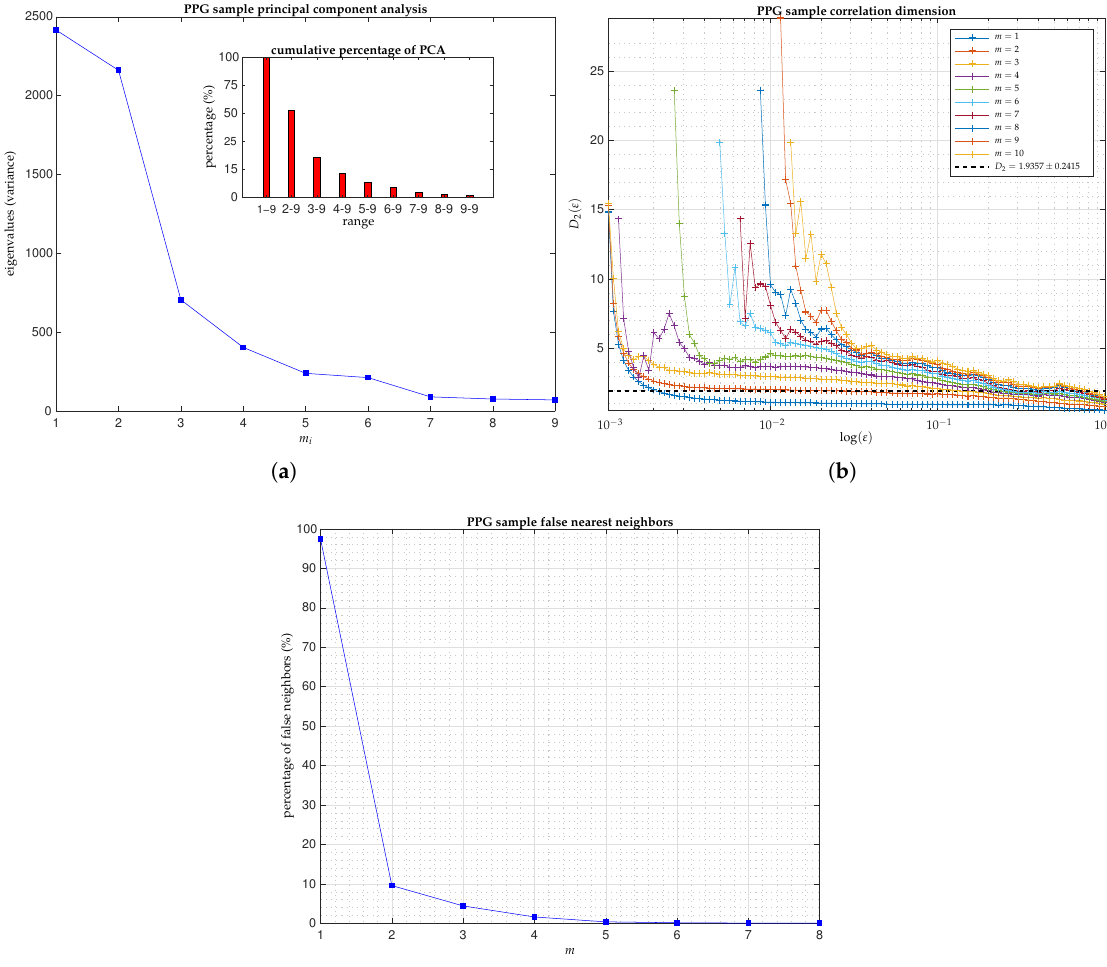
Figure 11. From a sample PPG signal (Subject Number 4): ( a ) Principal component analysis (PCA). The inner box clearly shows how the dynamic behavior of the attractor can be characterized with roughly seven directions. ( b ) Correlation dimension ( D 2 ). It can be seen how from m = 4, the correlation dimension was confined to a constant value in an intermediate and reduced range of scales ε . ( c ) False nearest neighbors. From m = 5, the number of false nearest neighbors is almost